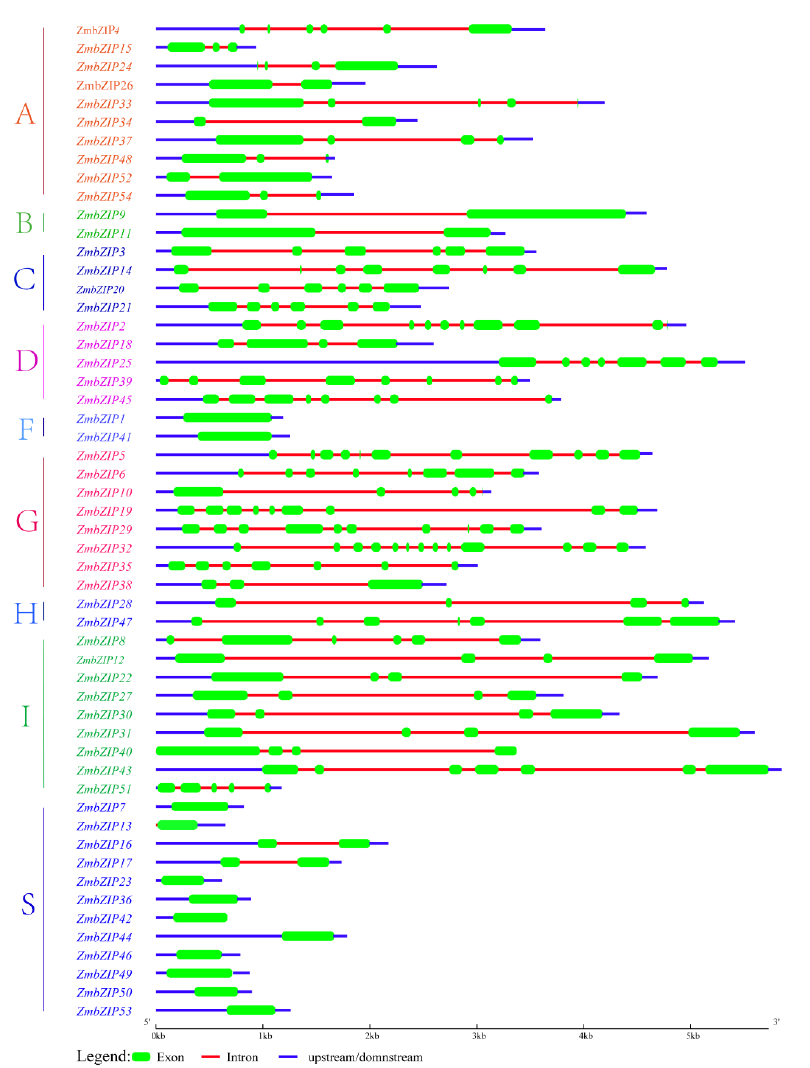
Figure 2. Gene structure of maize bZIP genes. Exon/intron organization of maize bZIP genes. Green boxes indicate exons and red lines represent introns, and the upstream and downstream regions are indicated by blue boxes. The sizes of exons and introns can be estimated using the scale at the bottom.